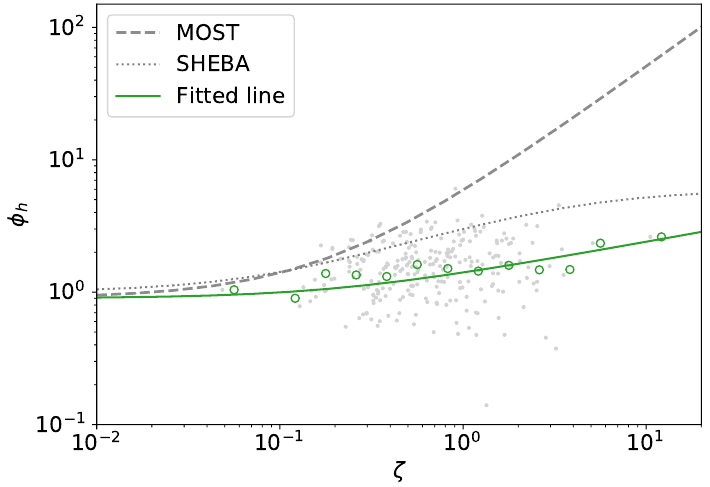
Figure 8. Same as Figure 6 but for φ h of the north